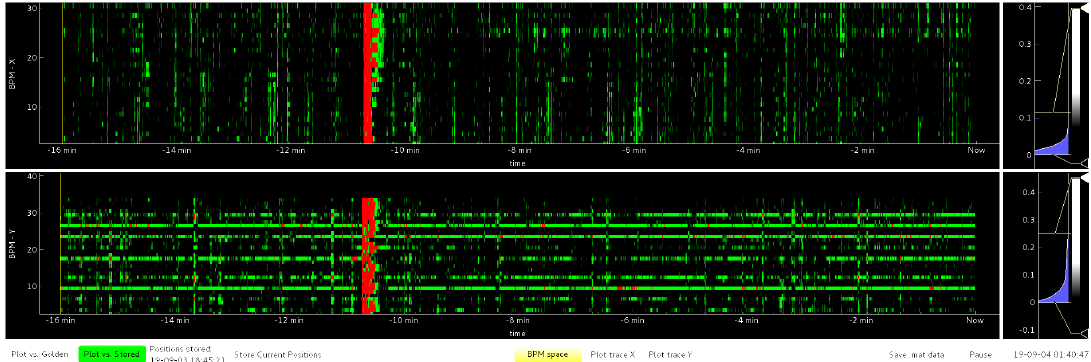
Figure 5. BPM trends in the horizontal ( top ) and vertical ( bottom ) planes for the 1.5 GeV storage ring. The vertical axis displays the BPM number, while the horizontal axis displays the time (in minutes). The thick vertical red lines seen in both planes are due to dipole kicker top-up injections, indicating large perturbations in the beam’s position, both in the horizontal and vertical